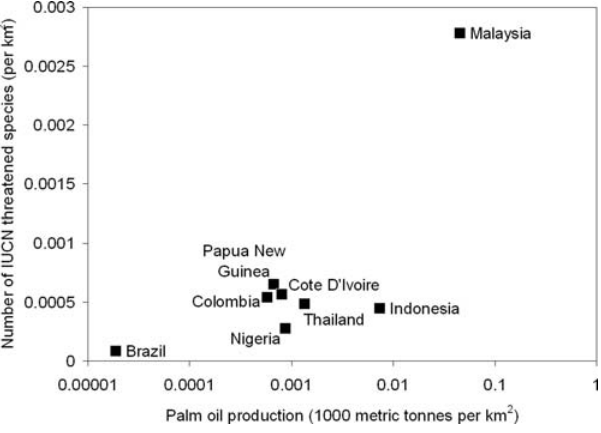
Figure 1. Number of threatened species per km 2 (IUCN Red List of Threatened Species [ 27 ] ) in relation to palm oil production per km 2 in 2005 [ 2 ] in the top eight palm oil producing